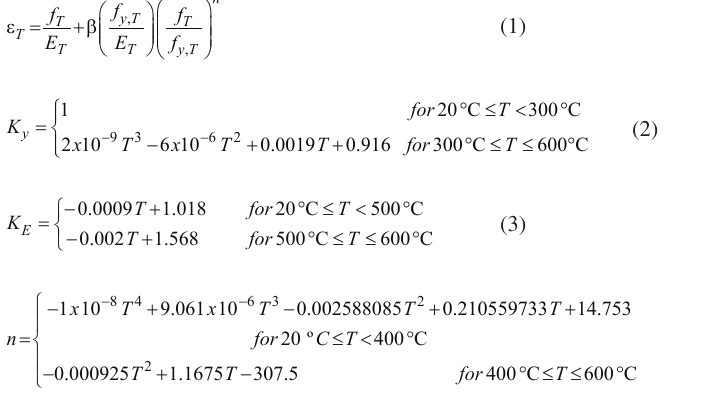
and (b) elastic modulus K y E